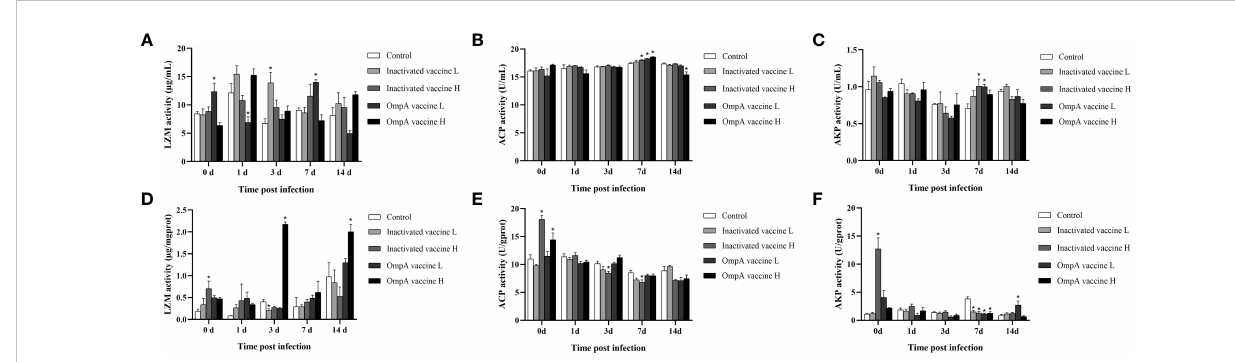
FIGURE 7 Effects of vaccination on the activities of serumal and hepatic antimicrobial enzymes of juvenile M. amblycephala upon infection. (A – C) represented the activities of LZM, ACP and AKP in the serum, respectively. (D – F) represented the activities of LZM, ACP and AKP in the hepatopancreas, respectively. Asterisk (*) represented a signi fi cant difference between the vaccinated groups and control group ( P <